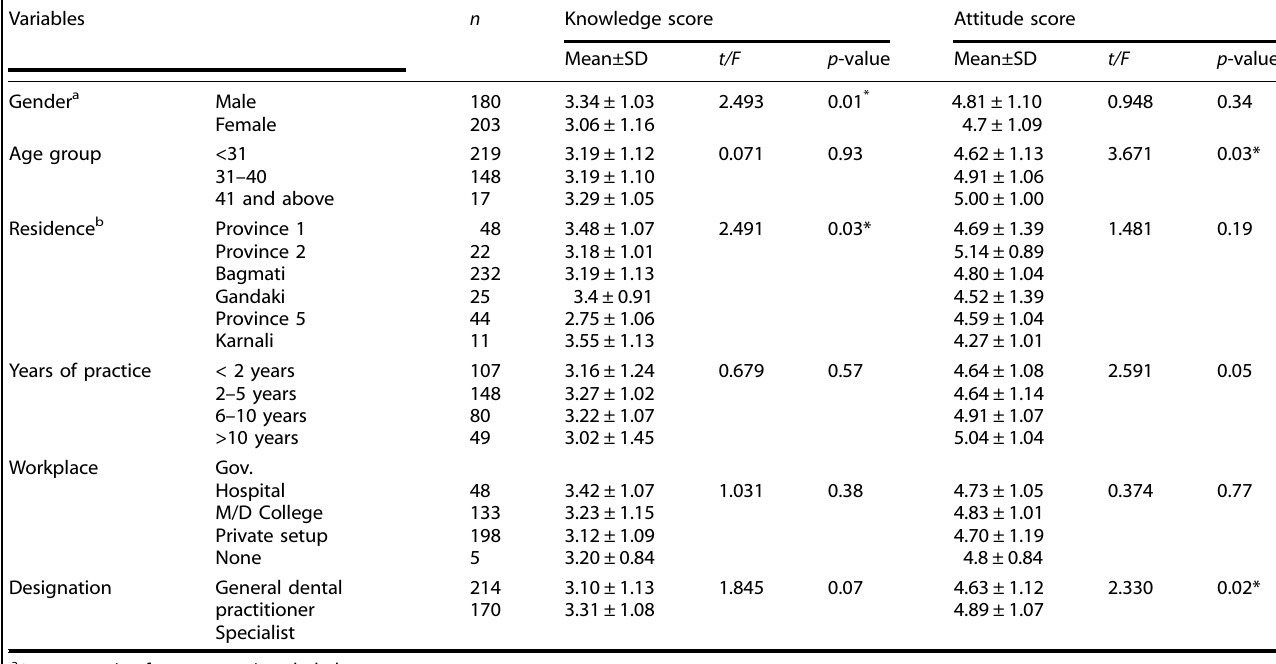
Table 4. Knowledge and attitude score of the aerosol transmission related to COVID-19 based on the sociodemographic characteristics of study